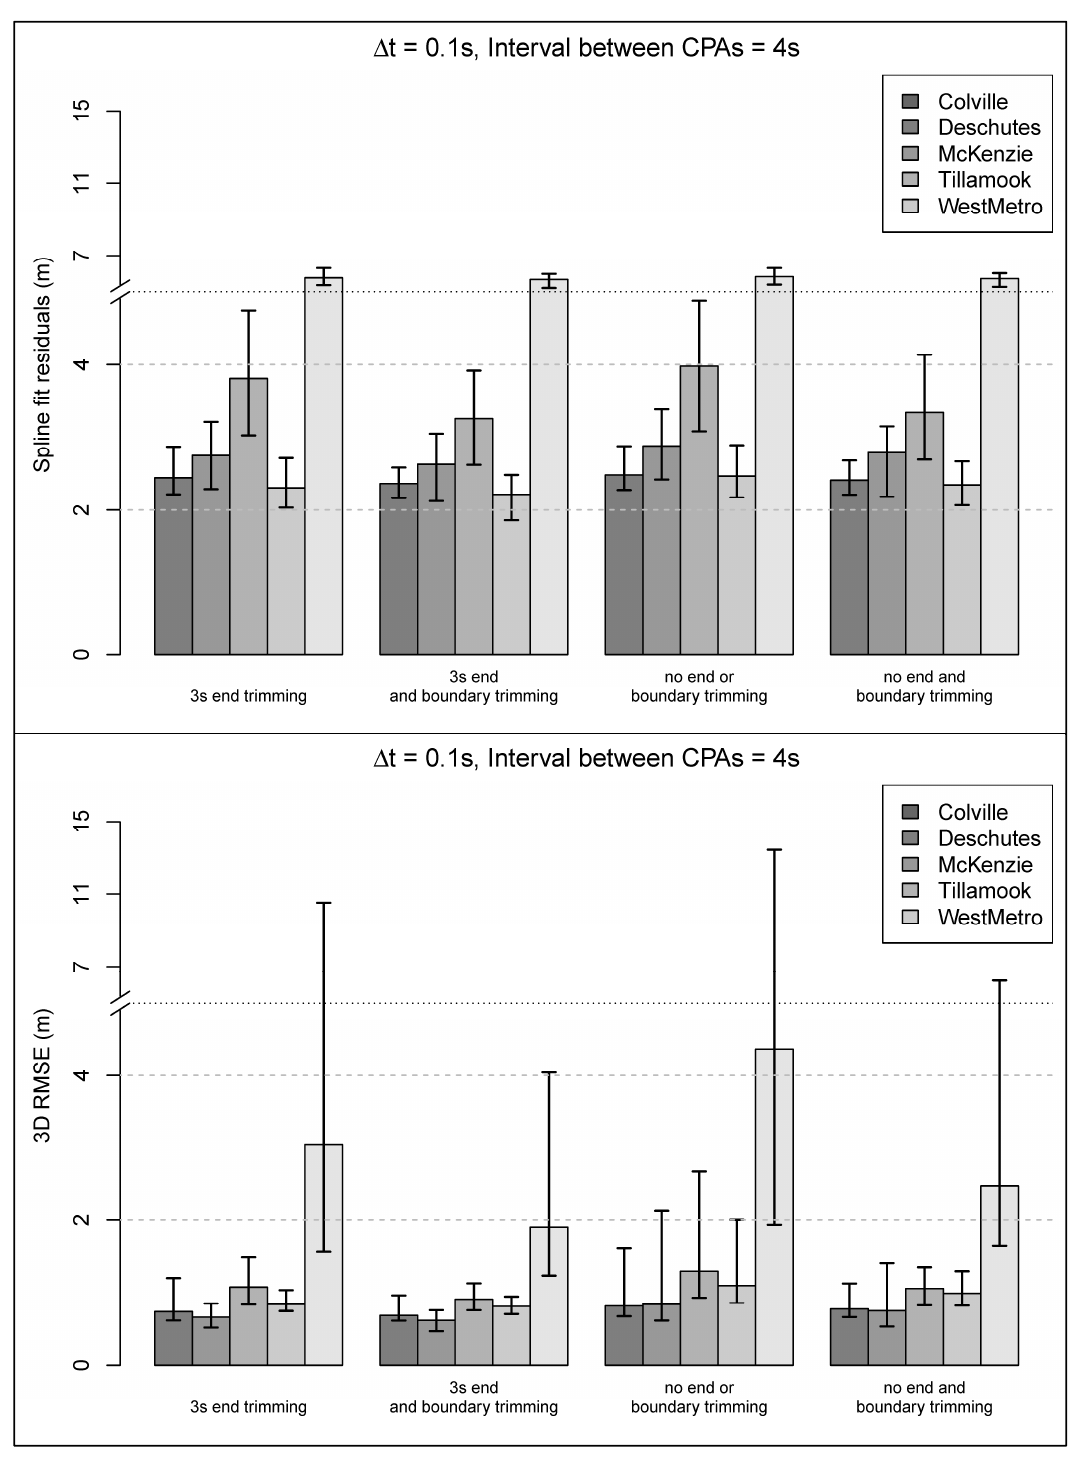
Figure 8. Distribution of residuals in splines fit to flight-line-specific CPA sets (top) and of spline error calculated using recorded platform positions (bottom) for a selected time block duration and time interval between CPAs. Bars represent the median and the whiskers the 25th and 75% percentile respectively. Note the scale discontinuities along the Y axis.